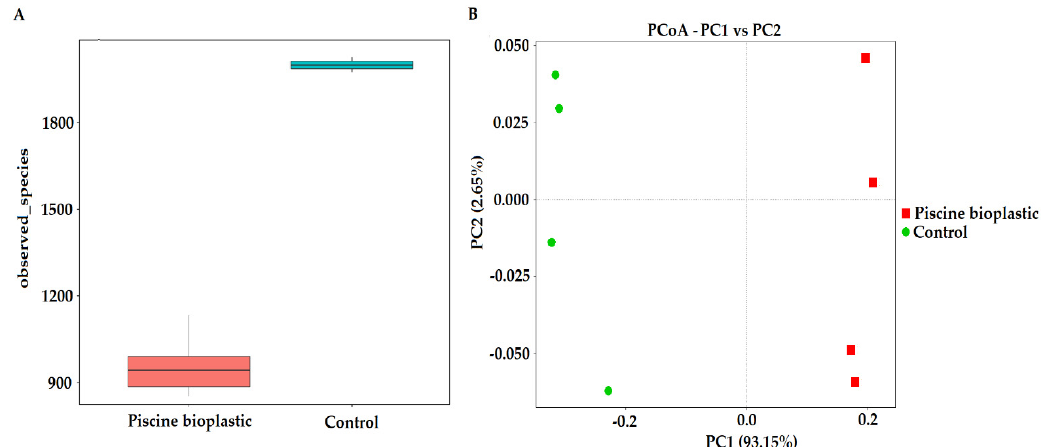
Figure 7. ( A ) Alpha diversity analysis based on number of observed species, ( B ) beta diversity analysis: PCoA based on weighted UniFract.